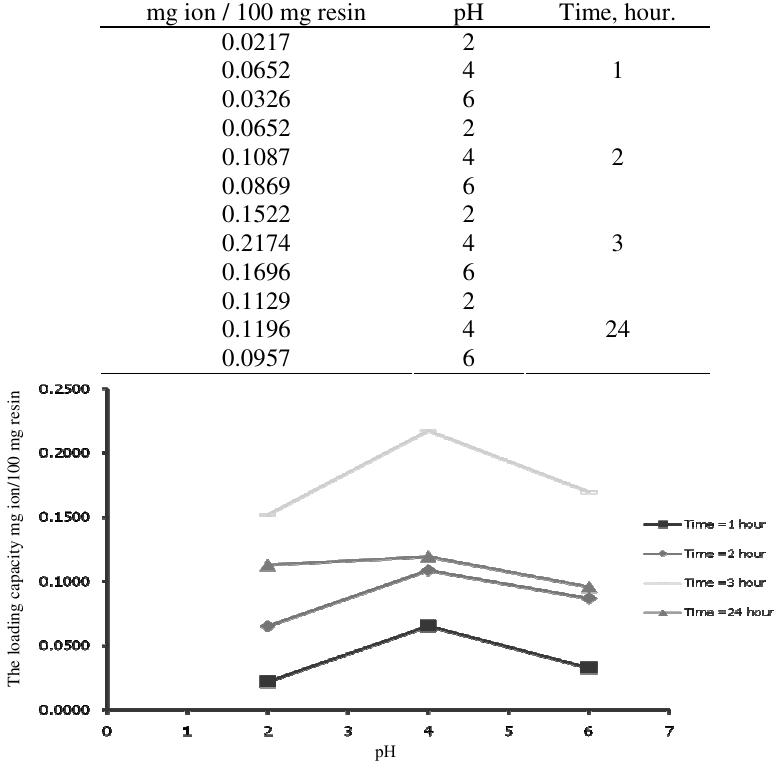
Figure 3. The effect of the pH on the loading capacity toward Cu(II)